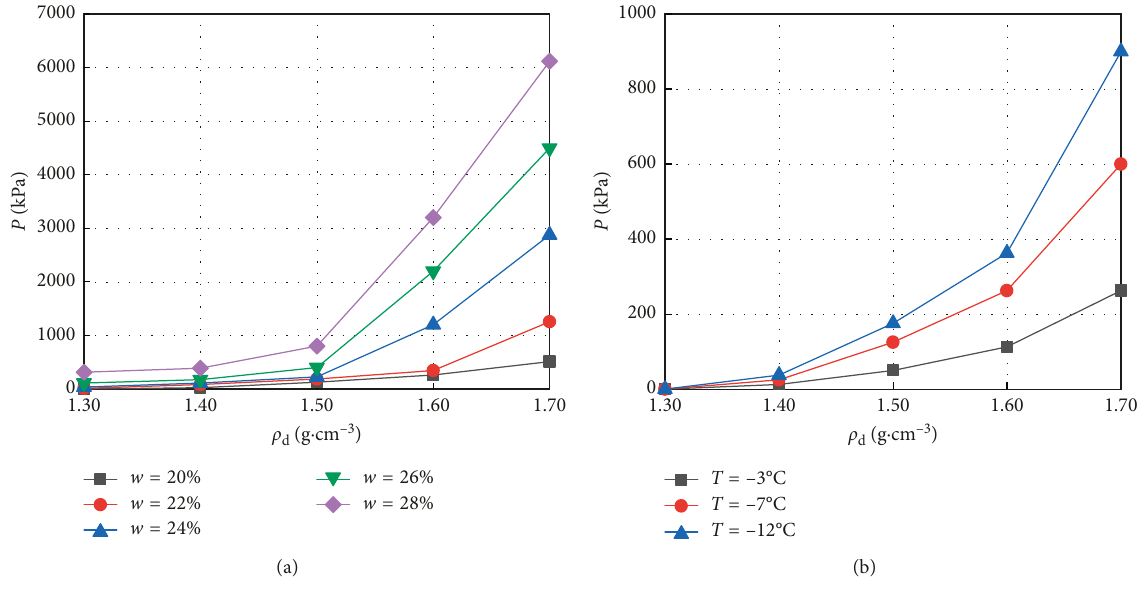
Figure 2: Relationship between dry density and frost-heave force. (a) T � − 7 ° C. (b) w �